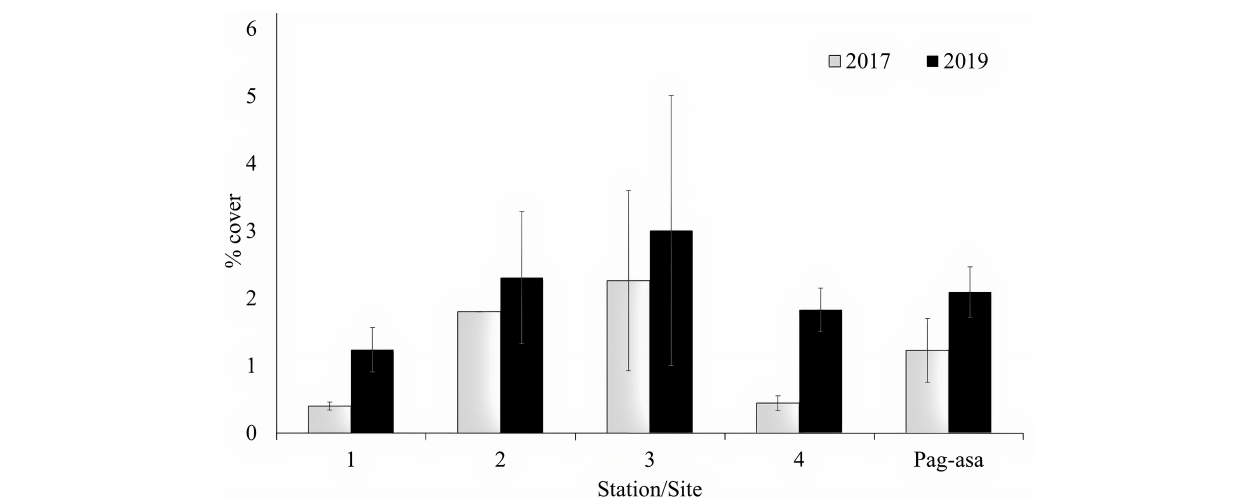
FIGURE 6 | Octocoral cover (mean ± SE) of the sampling stations in Pag-asa ( n = 4) monitored in 2017 and 2019. The last two bars represent means of the means (mean ± SE) of the four monitoring stations in different